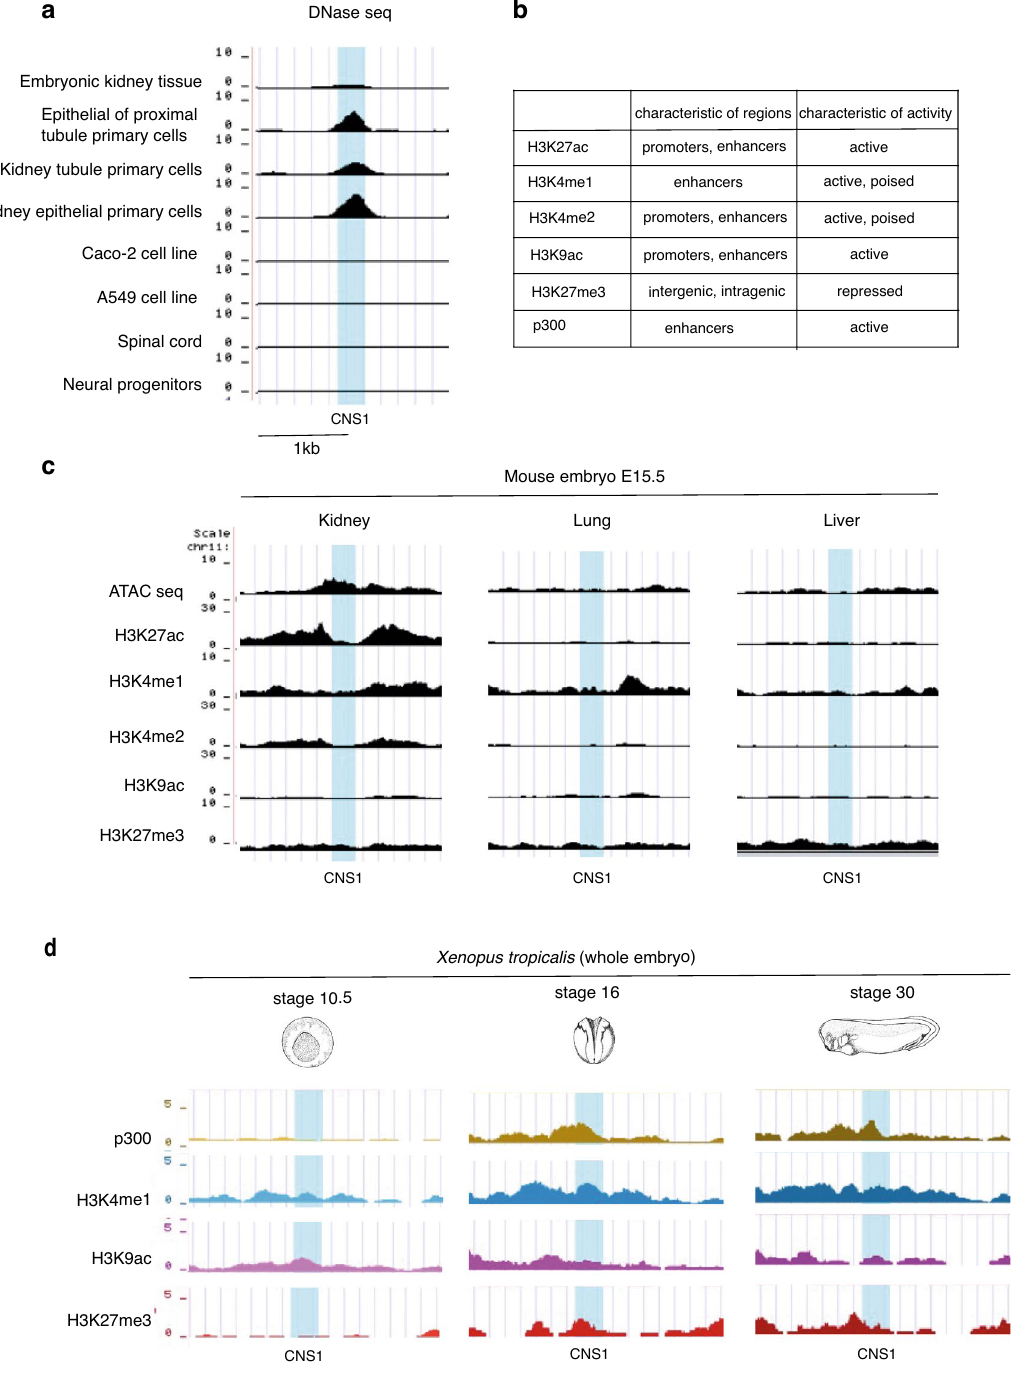
Figure 2. Chromatin signature of CNS1 region in Homo sapiens , Mus musculus and Xenopus tropicalis . ( a ) Snapshots of representative DNase-seq tracks from ENCODE database in human (https:// www. encod eproj ect. org) 25,26 . The overall profiles spanning a larger region including CNS2 and the description of the biological materials are shown in Fig. S1a. Open chromatin state is clearly detected at CNS1 level in embryonic kidney tissue and renal cells. In contrast, CNS1 is not accessible to DNase in non-renal cells expressing HNF1B (Caco-2 and A549 cells) as well as in spinal cord or neural progenitors where HNF1B is not expressed. ( b ) Characteristics of enrichment patterns for histone modifications and p300. ( c ) Snapshots of representative ATAC-seq and histone modifications tracks as indicated from ENCODE database (https:// www. encod eproj ect. org) 25,26 in kidney, lung and liver of E15.5 mouse embryo. The overall profiles spanning a larger region including CNS2 is shown in Fig. S2b. Although Hnf1b is expressed in developing kidney, liver and lung, CNS1 shows characteristics of an active enhancer only in the developing kidney. (d) Snapshots of representative p300 and histone modifications tracks as indicated from the epigenome reference maps in Ref. 27 in Xenopus tropicalis embryos at stages 10.5, 16 and 30. The overall profiles spanning a larger region including CNS2 is shown in Fig. S1c. CNS1 is associated with active enhancer marks (p300, H3K4me1) in embryos at neurula and tailbud stages (stage 16 and 30, respectively) when hnf1b is expressed in the developing pronephros but not at early gastrula (stage 10.5). In ( a,c,d ), the blue box indicates the 306-bp CNS1